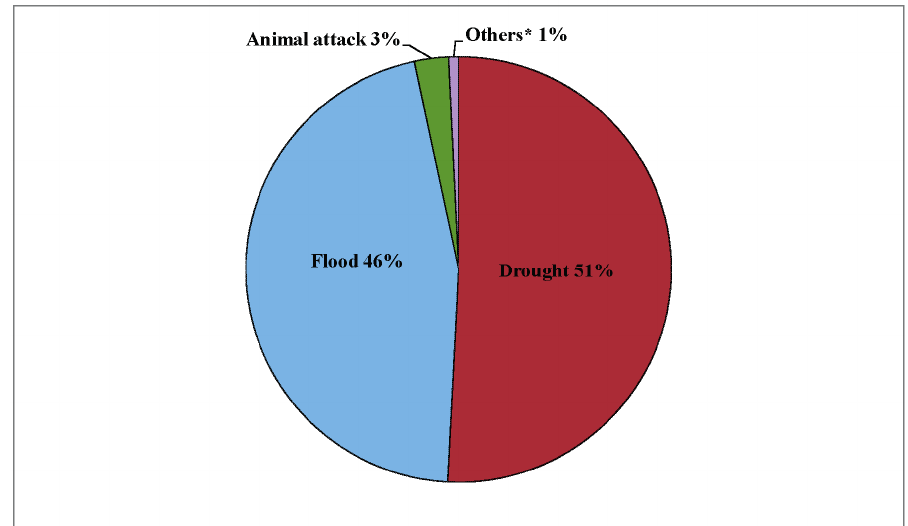
Figure 8. Effect of hazards on paddy cultivation,